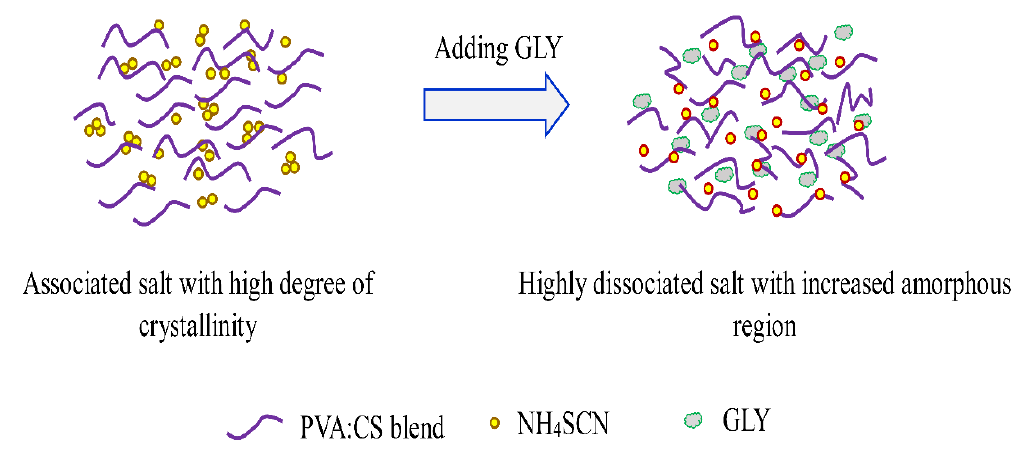
Scheme 1. Role of plasticizer on the ion dissociation and increase of